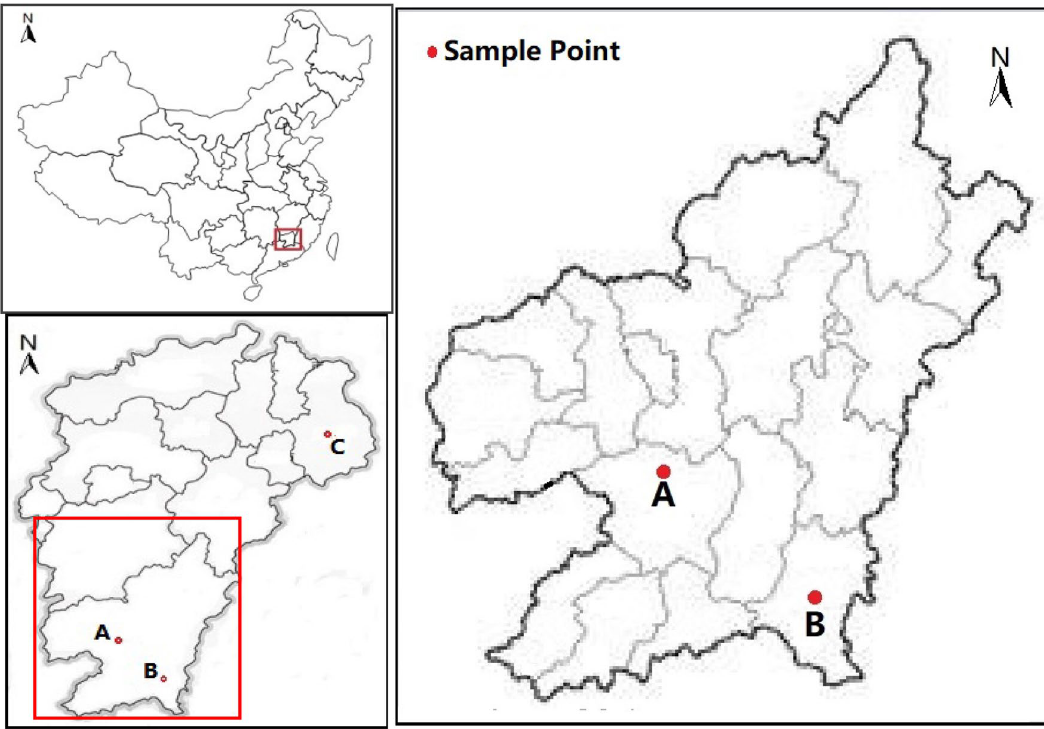
Figure 10. Distribution map of Sampling Points in Southern Jiangxi of China. Notes: “A” stands for Longshe Village, Jiading Town of Xinfeng County; “B” stands for Shipai Village, Wenfeng Town of Xunwu County. (The map is drawn by arcGIS 10.7, and URL is: https:// www. esric hina. com. cn/ ArcGIS/ arcgi s10_7. html/ onegr een. net/ maps/m/ jiang xi.